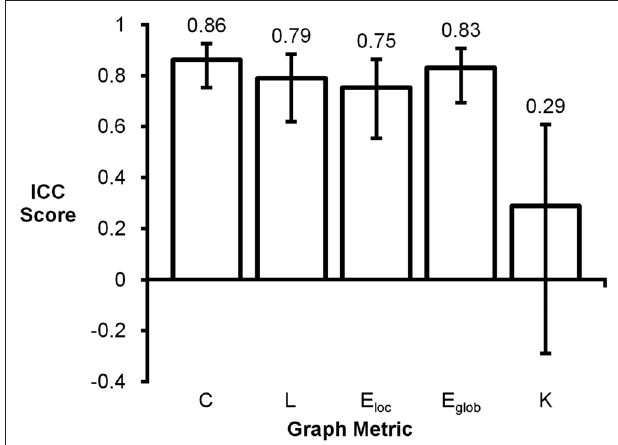
FIguRe 2 | Intraclass correlation coefficient plot of mean graph metrics. Clustering coefficient ( C ), global efficiency ( E path length ( L ) were found to be highly reproducible while degree ( K ) had a noticeably lower ICC